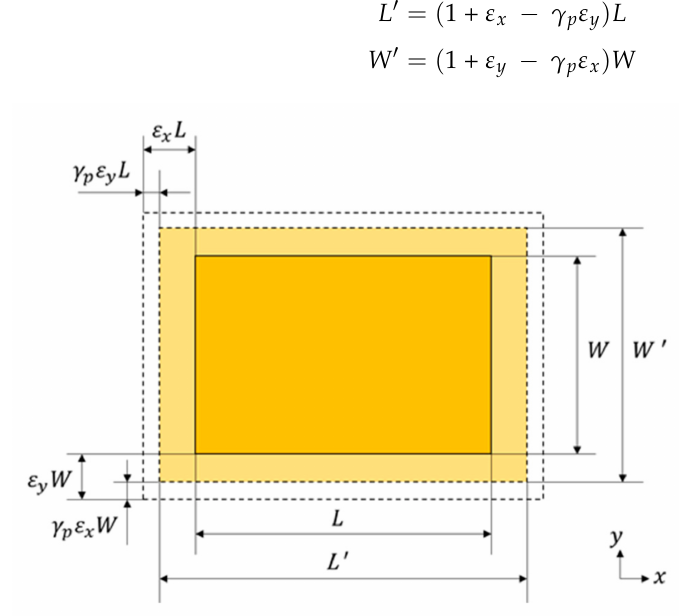
Figure 3. Deformation diagram of the patch under